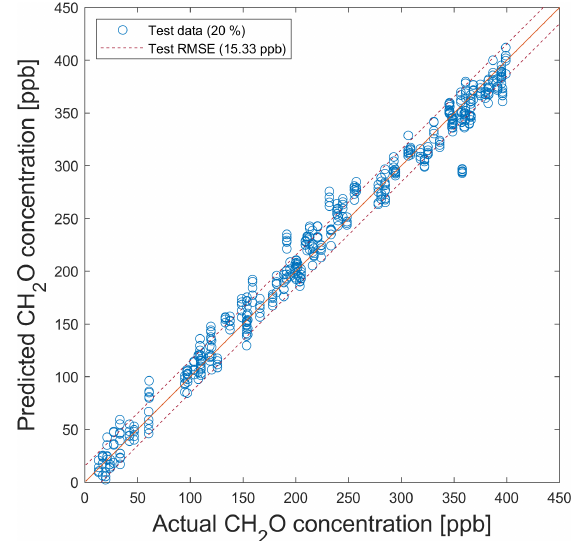
Figure 7. PLSR model for the quantification of formaldehyde for testing with test data from the data split shown in Fig. 5. Dashed lines indicate the RMSE of the test data (T − RMSE).